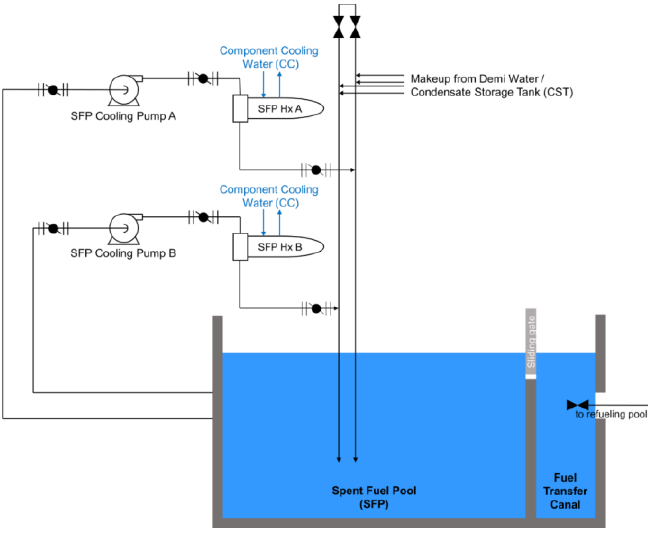
Figure 1. Schematic of current SFPCCS. Table 2. Comparison of estimated total costs for SFPI and dry casks.